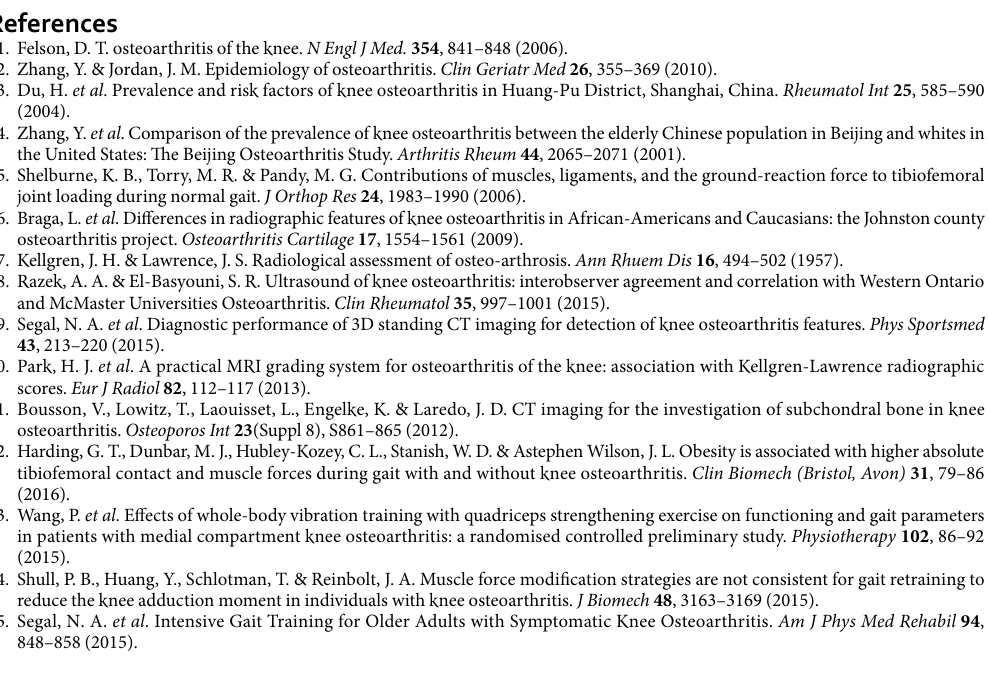
a frequency of 60 Hz. We used a hand-held digitizing probe to identify nine bone landmarks to set the 3D position of the tibia and the femur, and collected trajectories of the femur relative to the tibia (Fig. 4). Finally, we calculated the kinematic data (6DOF) with the workstation computer as the participants walked on the treadmill, including flexion/extension, adduction/abduction, internal/external femoral rotation, anteroposterior translation, proxi- mal/distal translation and medial/lateral translation of the knees. Before data collection, each participant was trained to adapt to walk on the treadmill. Hence, the participants could walk on the treadmill at 2.0 km/h as if they were walking on the ground. Finally, we recorded the data for 15 s of gait at a speed of 2.0 km/h. The total testing time for each participant was within 10 min. 6DOF were calculated from the trajectories of the femur relative to the tibia. The average from all gait cycles of each participant was calculated and divided into two phases: stance phase (~62% of the gait) and swing phase (~38% of the gait) 38 . We calculated the range of motion of 6DOF and knee kinematics at the time of heel strike, 50% of the stance phase and maximum motion of 6DOF at the swing phase, which reflected the status of the knee kinematics in patients with knee OA 30, 38 . We compared the differences using One-Way Analysis of Variance (ANOVA). The Bonferroni correction was performed between groups when significant differences were detected.